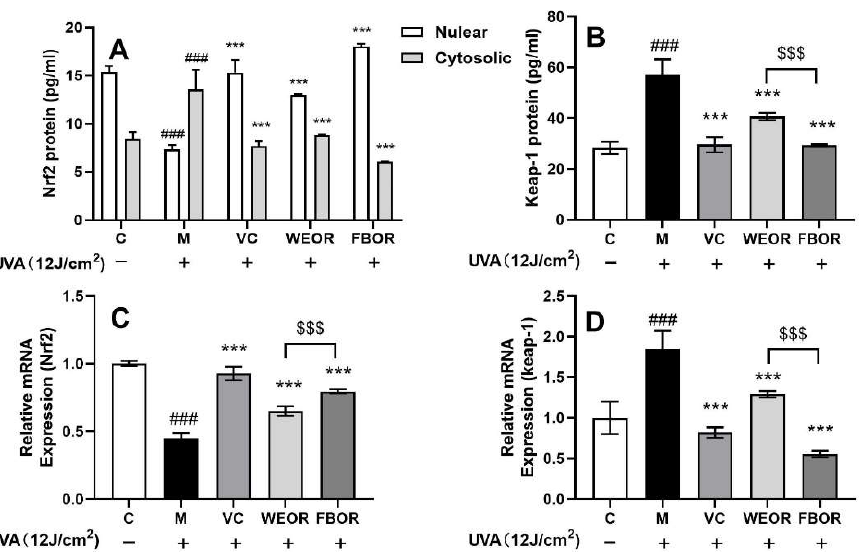
Figure 4. WEOR and FBOR activate the Nrf2-Keap-1 pathway: ( A ) Cytoplasmic Nrf2 protein content; Nuclear Nrf2 protein content; ( B ) Intracellular Keap-1 protein content; ( C ) Relative expression content of Nrf2 mRNA factor; ( D ) Relative expression content of Keap-1 mRNA factor. (*** p < 0.001, versus the UVB irradiation model group; ### p < 0.001, versus the control group. $$$ p < 0.001, the WEOR group versus the FBOR group. C: Control group; M: UVB irradiation model group).